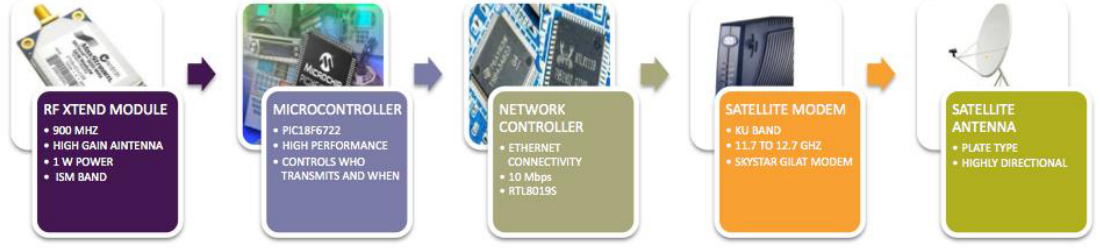
Figure 5. Main components of the Remote Base